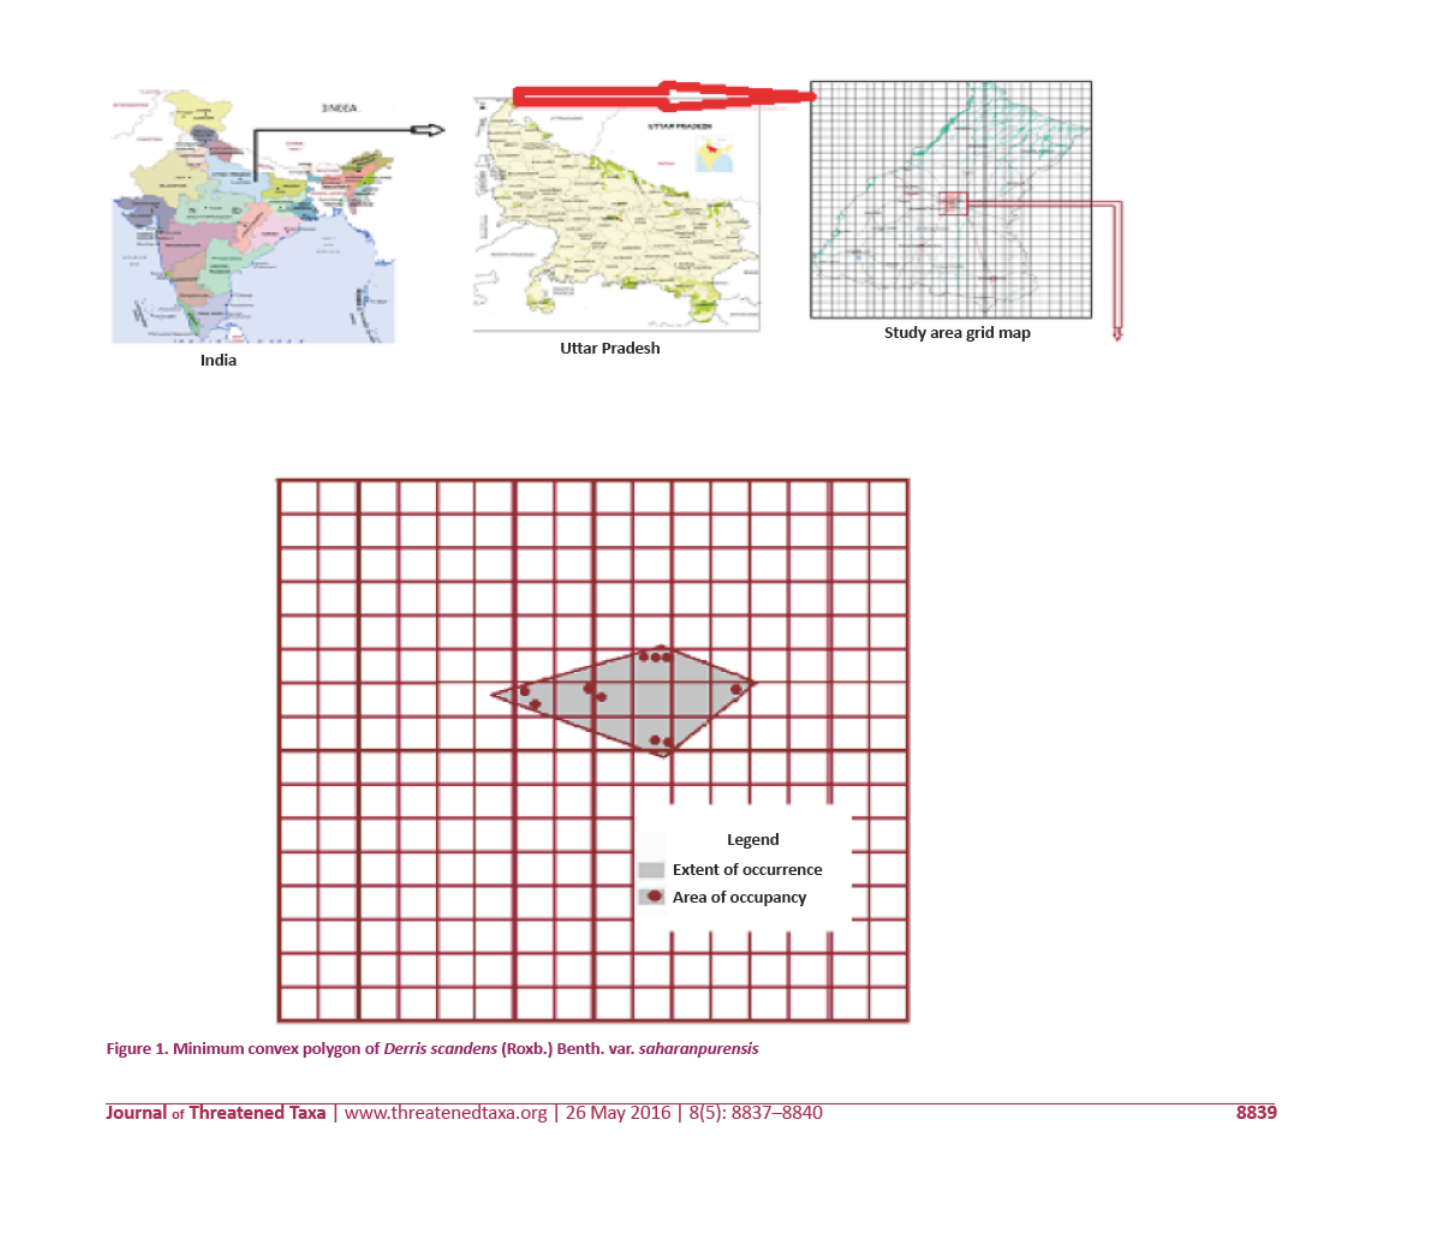
Ffigure 1. Mfinfimum convex polygon off Derrfis scandens (Roxb.) Benth.